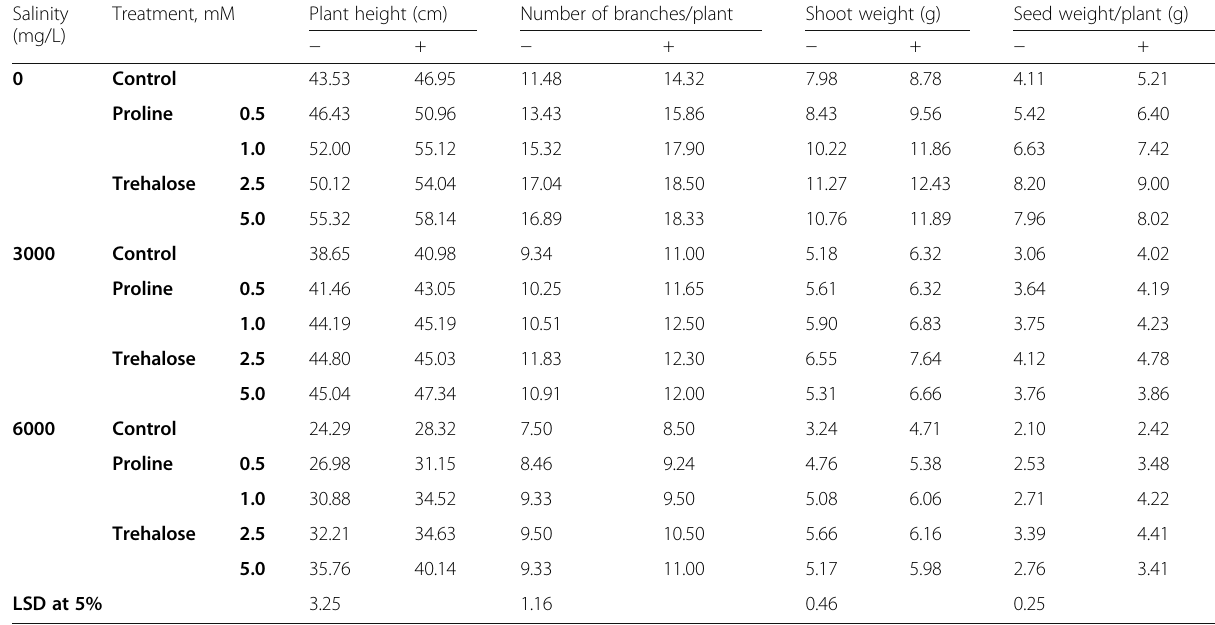
Table 7 Yield parameters of quinoa plants treated with proline or trehalose with (+) and without ( − ) compost amendment under salinity stress (average of two seasons) Salinity Treatment, mM (mg/L) 0